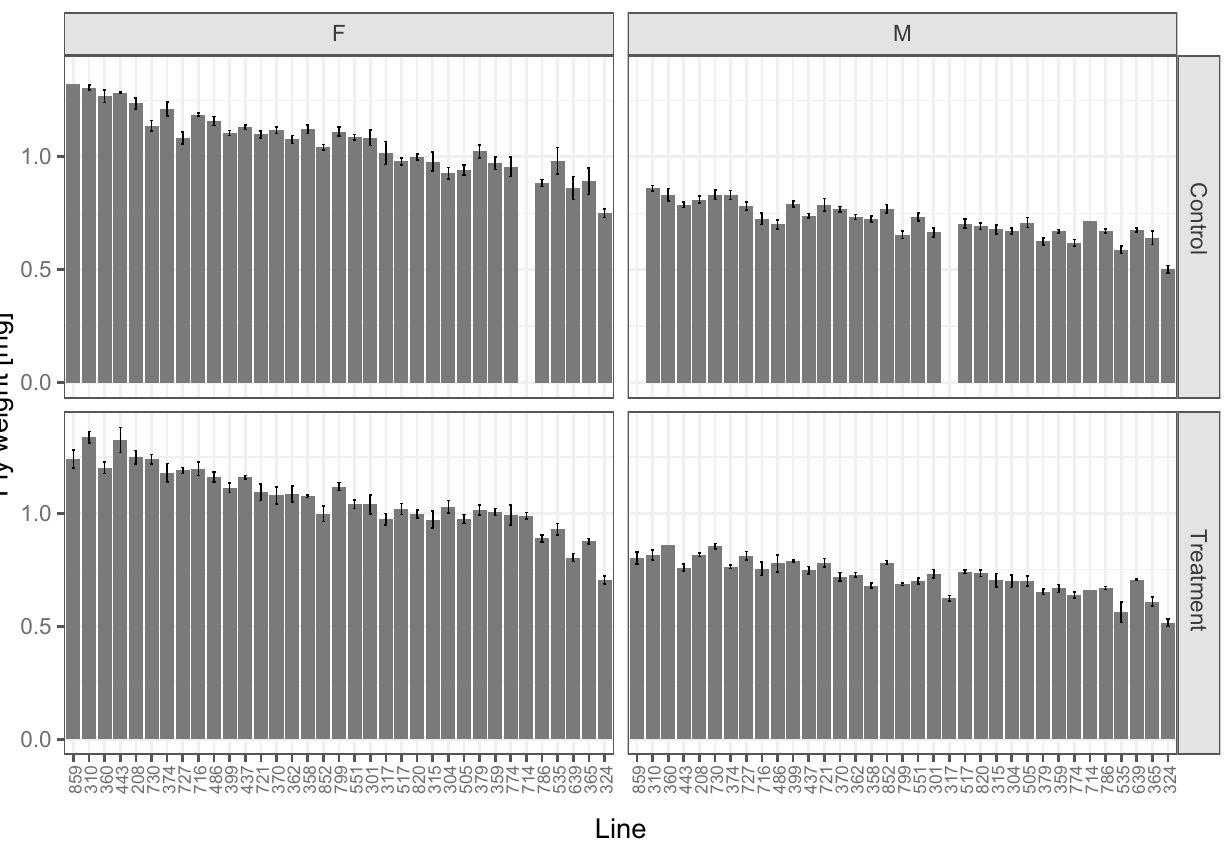
Figure 2. Weights of flies in 38 DGRP strains vary considerably, both with and without exercise treatment. Bar graphs showing group means ± standard error for weights per fly in mg (Y-axis). The lines are arranged from the highest to lowest overall weight. Top left—data from female (F) control animals; top right—data from male (M) control animals; bottom left—data from female exercise-treated animals; bottom right—data from male exercise-treated animals. Missing data for a specific line/sex/ treatment combination results in missing bars in the graph.